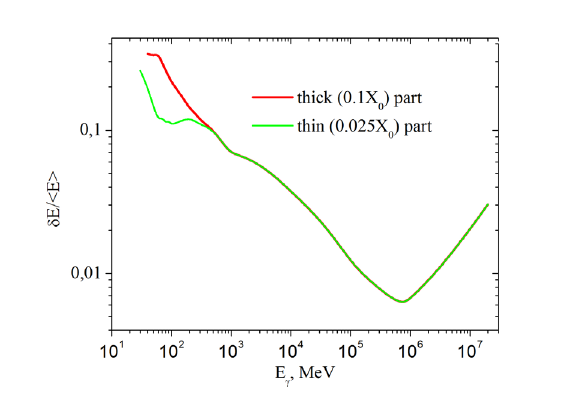
Figure 3. The dependence of the e ff ective area vs the energy for Figure 5. The dependence of the energy resolution vs the energy for two parts of the converter: 4 panels with W = 0.025X 0 and 7 panels with W = 0.1X 0